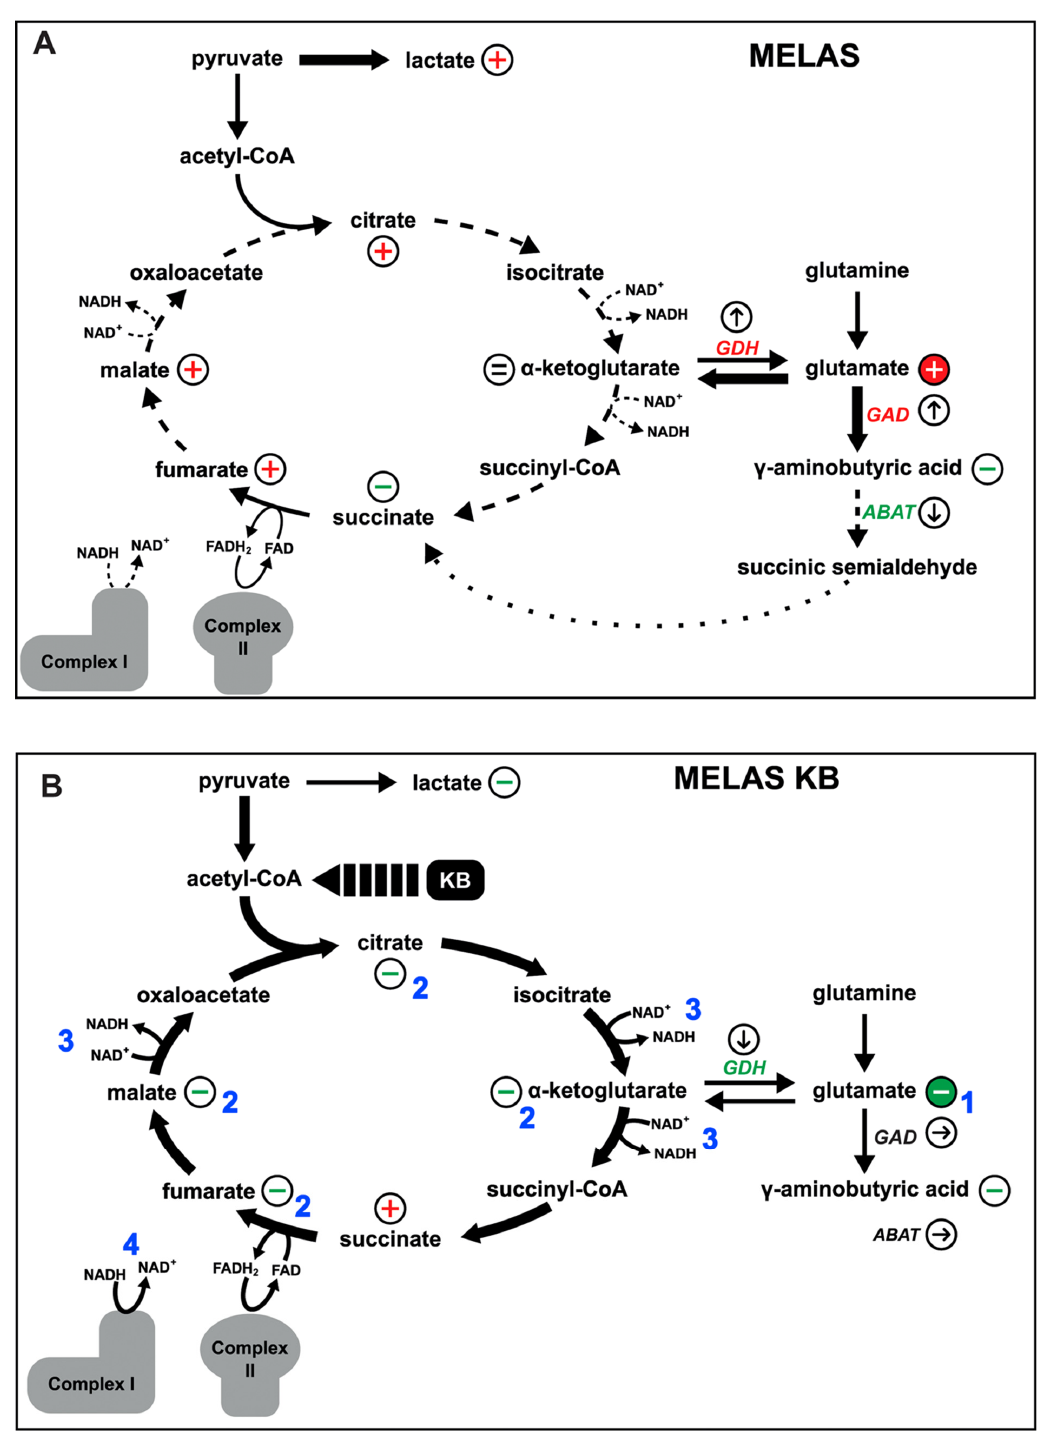
Figure 9. Graphical representation of metabolic pathways of MELAS cells ( A ) untreated ( B ) or treated with ketone bodies (KB). +: metabolite increase. –: metabolite reduction, = metabolite unchanged. ↑ : increased gene expression. ↓ : decreased gene expression. Metabolic consequences of KB treatment on mitochondrial metabolism are summarised in 4 main steps: 1. significant reduction of glutamate concentration; 2. reduction of the accumulation of TCA intermediates restoring the physiological function of the TCA cycle; 3. re-equilibration of the redox/NADH balance; 4 improving complex I enzyme